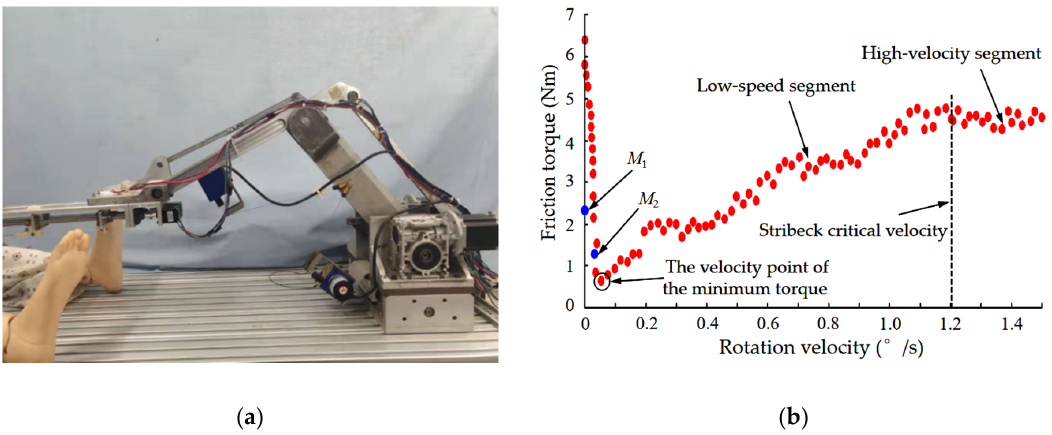
Figure 3. Diagram of the machine structure and test data. ( a ) Cantilevered prostate seed implantation robot, ( b ) experimental data diagram of friction torque and rotation rate.